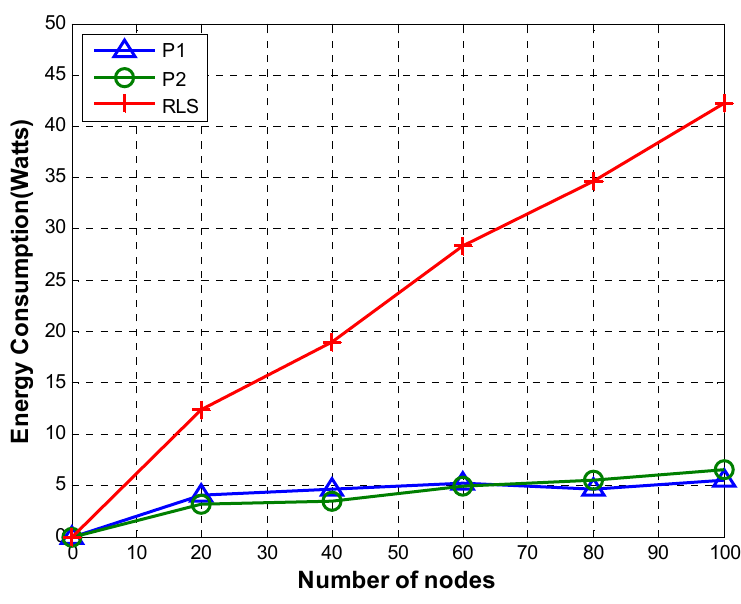
Figure 12. Energy consumption.